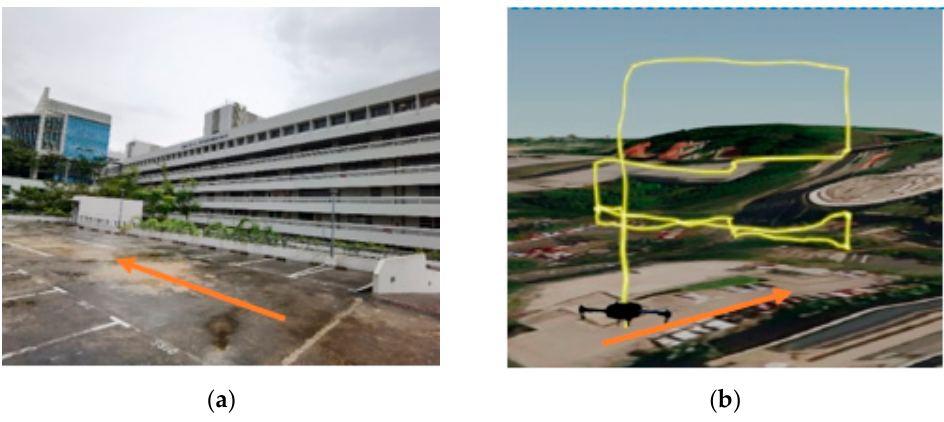
Figure 3. ( a ) Carpark N2.1, NTU. ( b ) Flight Path at Carpark N2.1.